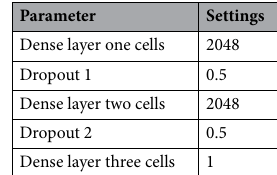
Table 3. Network settings for discrimination layers.